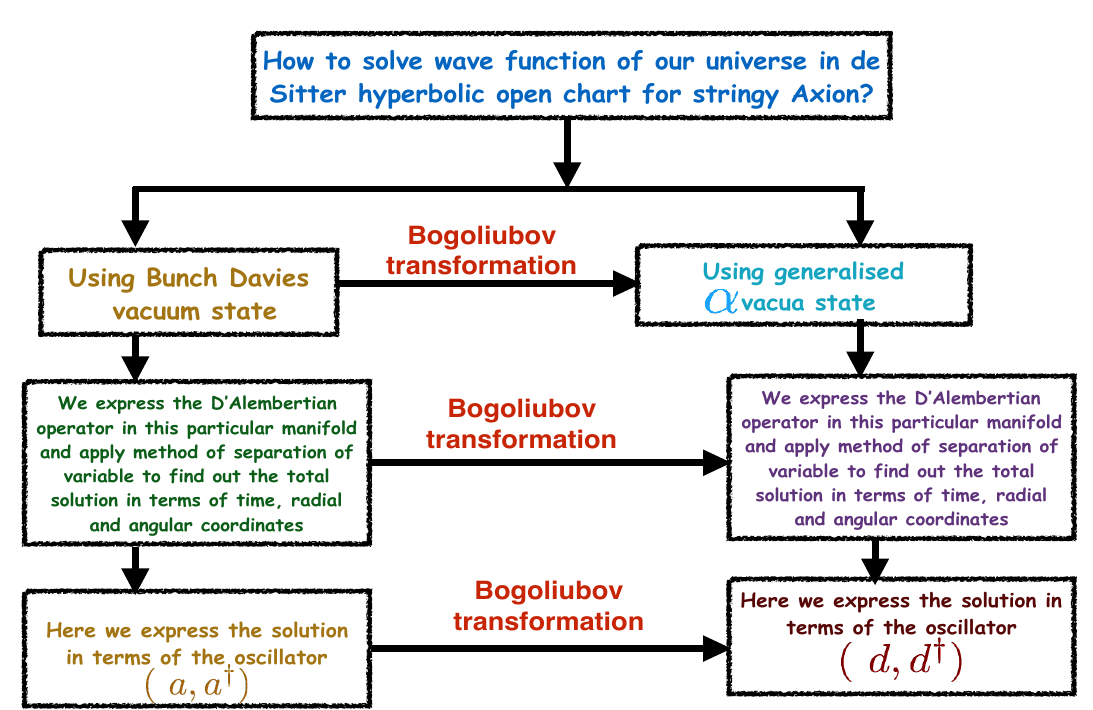
Figure 4. Schematic diagram for the computation algorithm of solving the wave function of our universe in de Sitter hyperbolic open chart for stringy